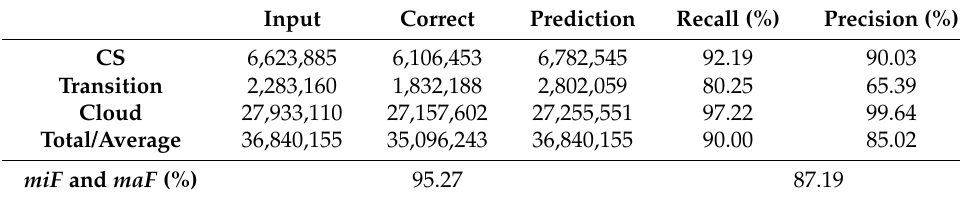
Table 4. Summary of evaluation of three CSM types in daytime, 21 February